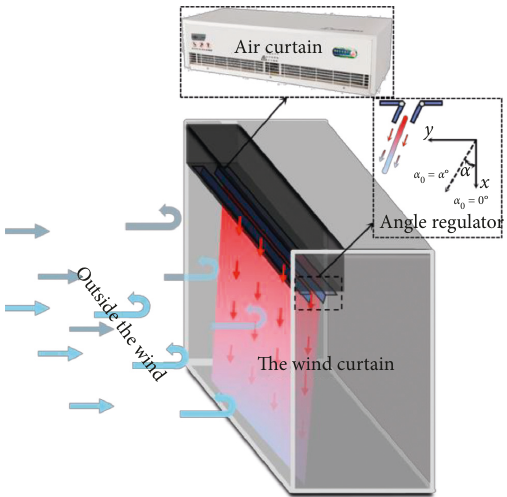
Figure 3: Installation diagram of tunnel air